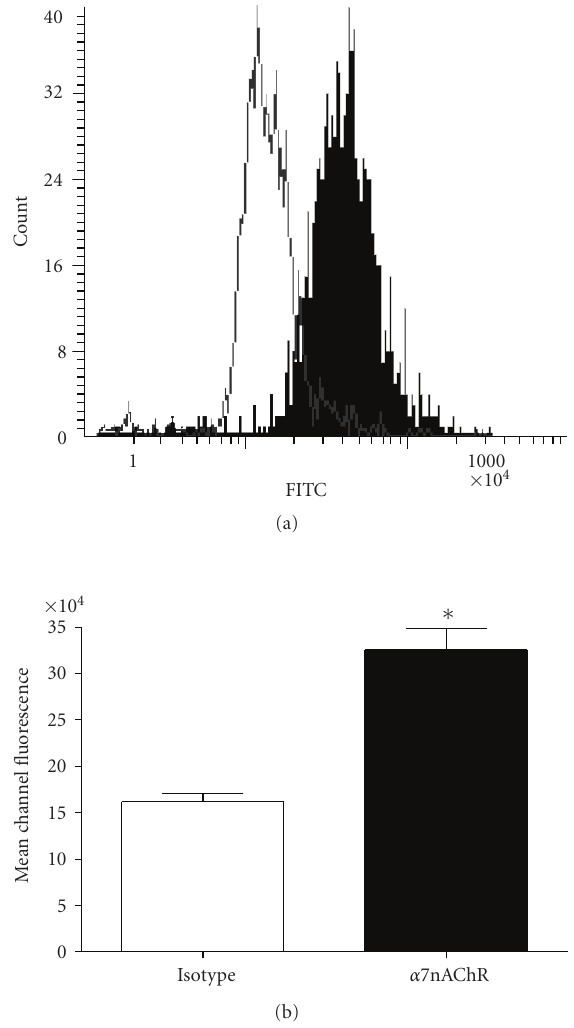
Figure 6: CFTE29o- cells express the α 7-nAChR. CFTE29o- cells (1 × 10 5 /mL) were grown in chamber slides, Fc-blocked, and labelled with FITC-conjugated anti- α 7-nAChR or isotype control antibodies. Cells were counterstained with PI, and α 7-nAChR surface expression was quantified by laser-scanning microscopy. (a) Representative histogram of FITC fluorescence comparing isotype (clear) and anti- α 7-nAChR (solid) antibody-labelled samples. (b) Histogram showing median channel fluorescence ± SEM ( ∗ P ≤ . 05, n = 6).